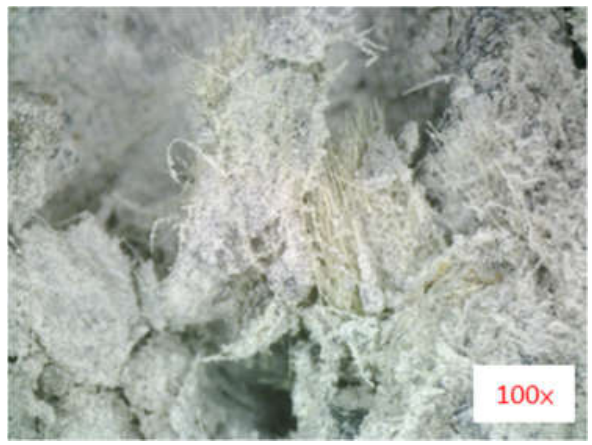
Figure 11. Impact failure images of the I-M5/5 mix-proportion KFRC specimen by using a digital optical microscope.